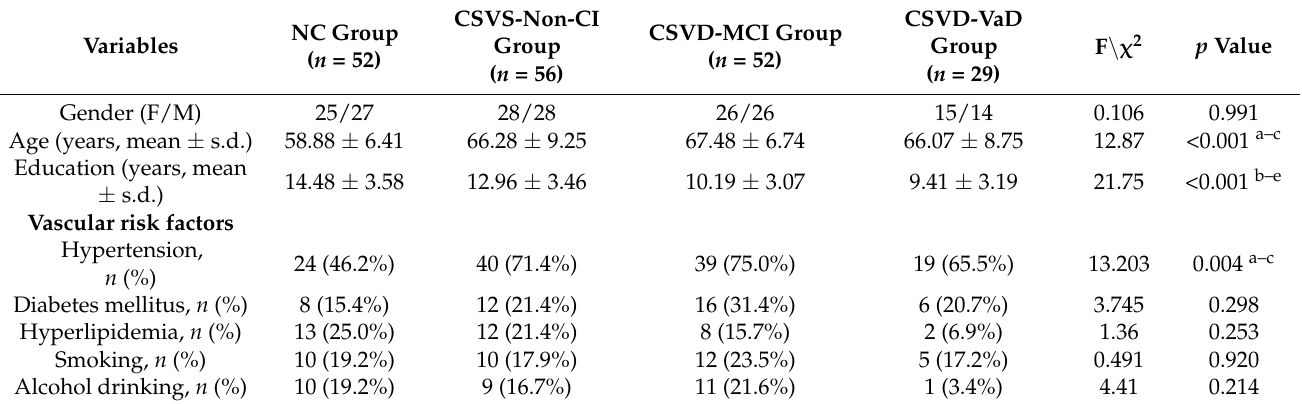
Table 1. Demographics of the participants enrolled in this